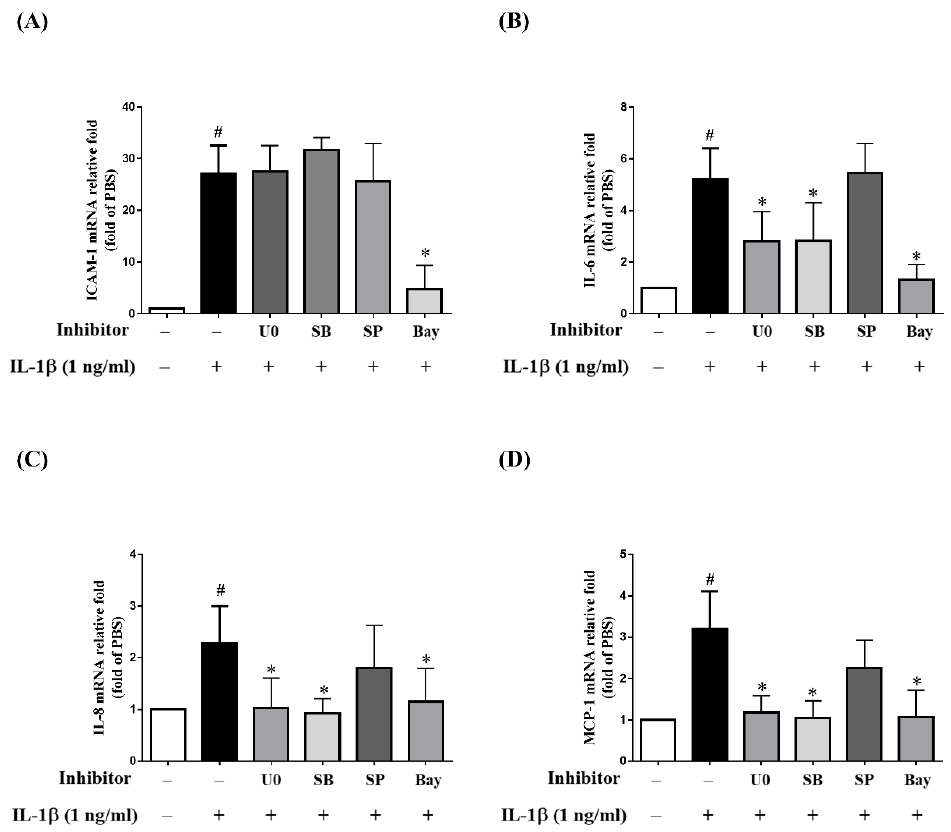
Figure 7. Inhibitory effects of MAPKs and NF- κ B inhibitors on the expression of mRNA for ICAM-1, IL-6, IL-8 and MCP-1 in IL-1 β -stimulated ARPE-19 cells. ARPE-19 cells were treated with 10 µ M U0126 (U0), 10 µ M SB202190 (SB), 10 µ M SP600125 (SP) or 5 µ M Bay11-7082 (Bay) for 1 h, followed by stimulation with 1 ng / mL IL-1 β for 4 h. The fold changes in ( A ) ICAM-1, ( B ) IL-6, ( C ) IL-8 and ( D ) MCP-1 gene expression were analyzed using RT-qPCR with β -actin as an internal control. The data are expressed as mean ± SD of three independent experiments. # p < 0.05 versus control cells. * p < 0.05 versus IL-1 β -stimulated cells.